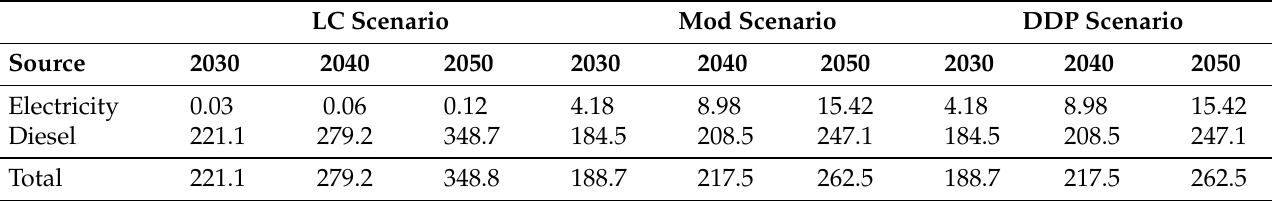
Table 7. Freight land transport demand in PJ.